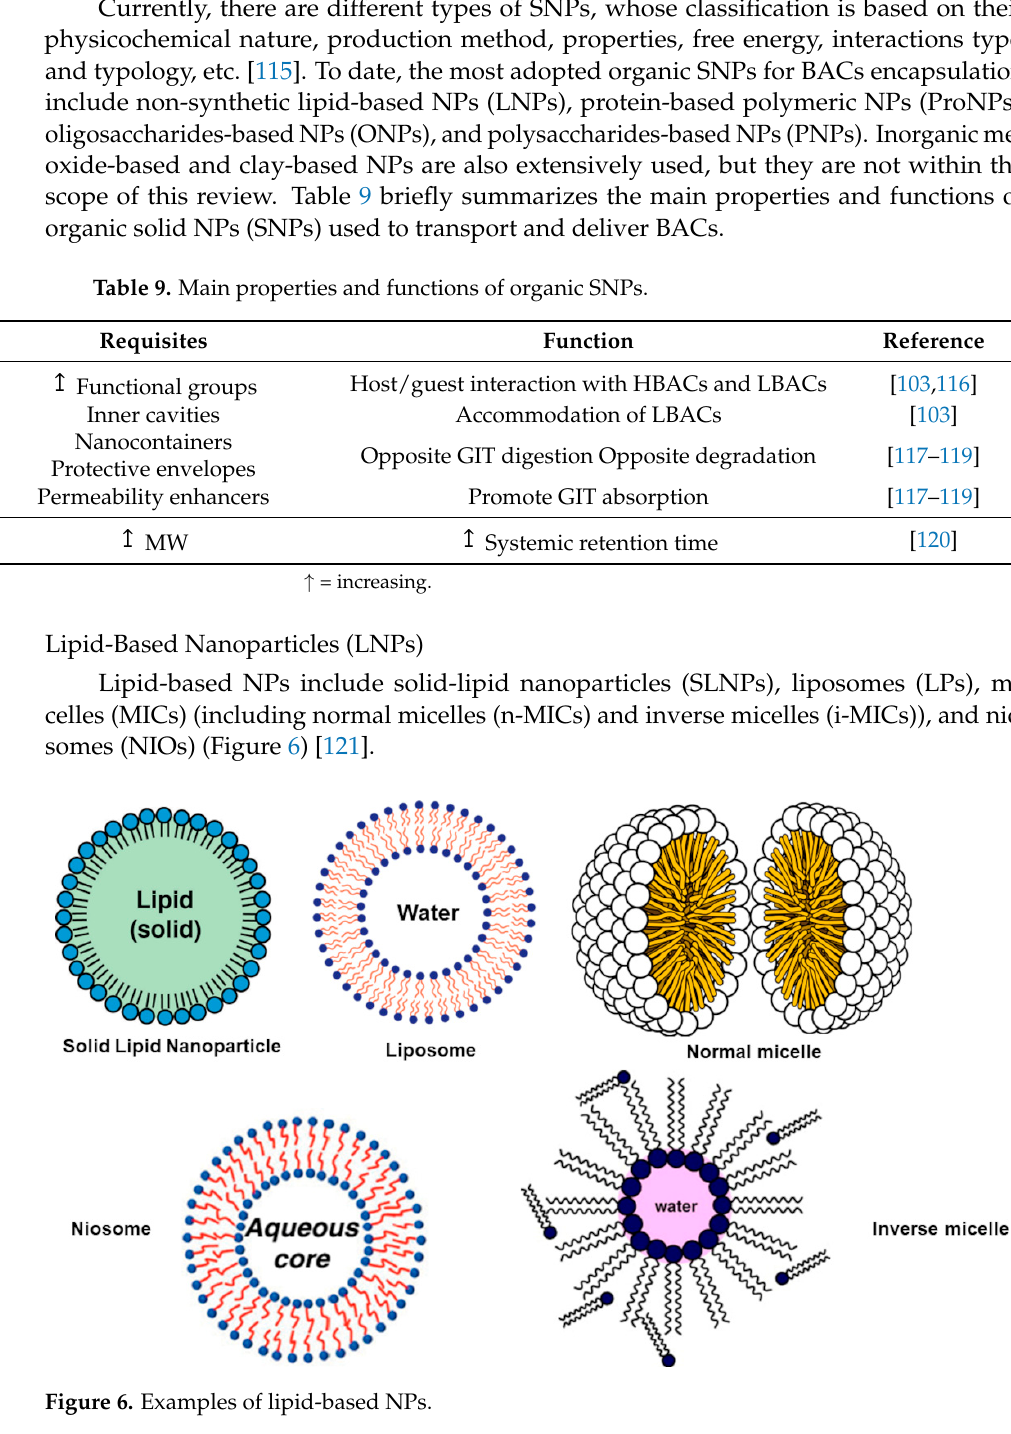
Table 8. Examples of nanosized formulations of BACs developed by using the abovementioned polymers. Table 9. Main properties and functions of organic SNPs.